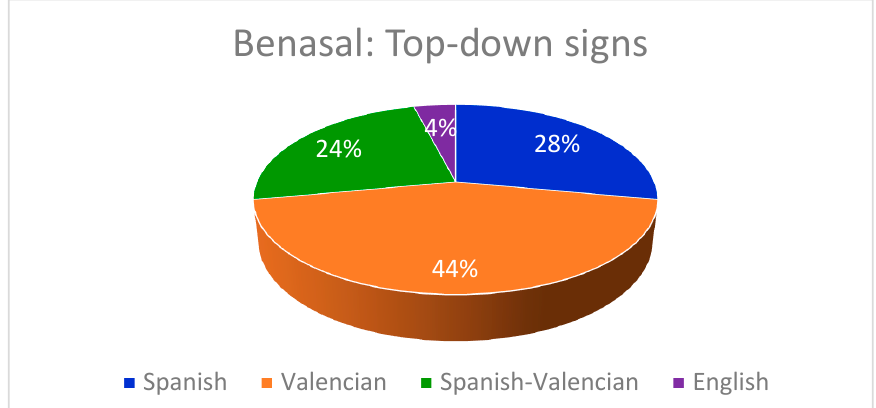
Figure 1. Benasal: Top-down signs .